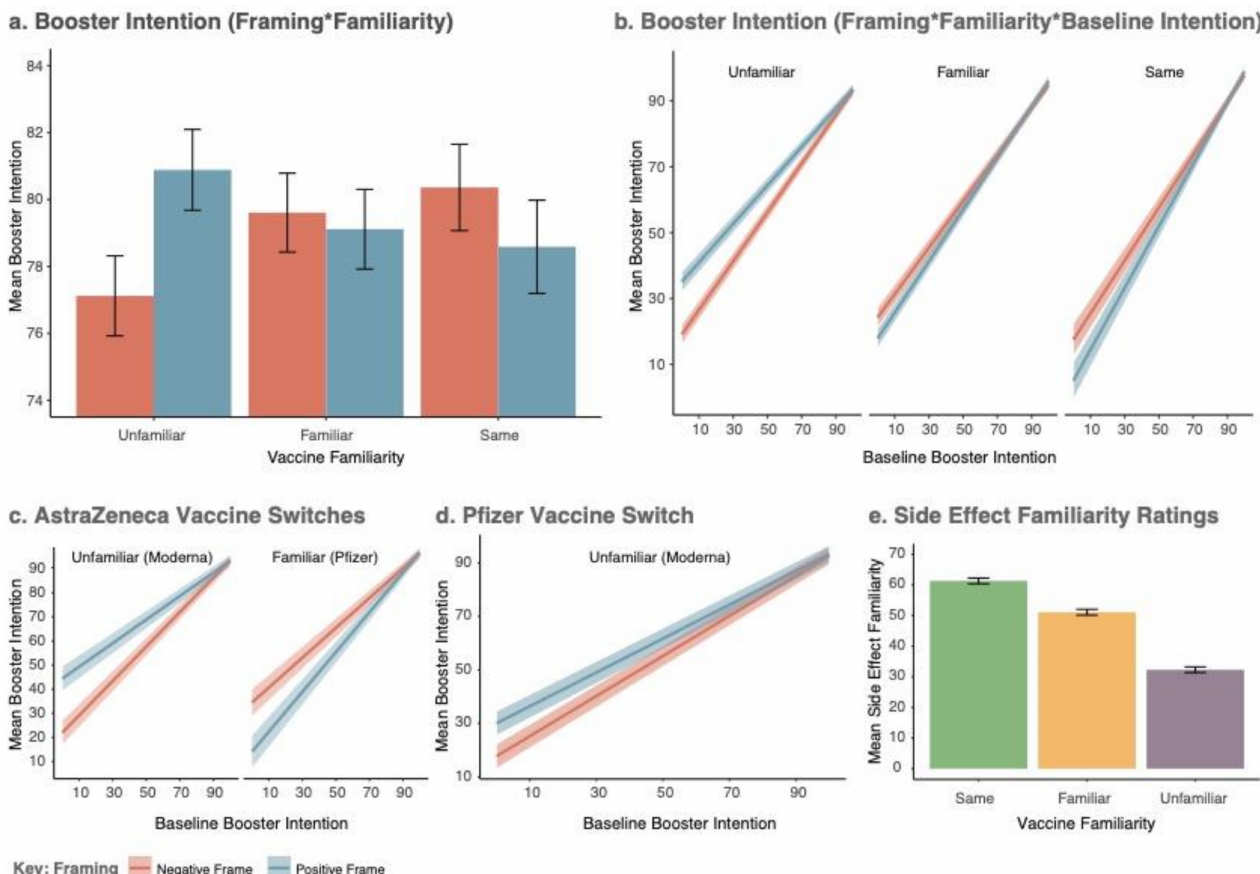
Figure 4. Model estimated mean differences in the primary outcome (Booster Intention), depicted for the whole sample (( a , b ); sample size by condition presented in Table 1), and for realistic switches occurring as part of the UK booster programme (( c , d ); AstraZeneca/Unfamiliar N = 206, As- traZeneca/Familiar N = 204, Pfizer/Unfamiliar N = 202, sample size by condition presented in Figure 2). ( e ) presents data demonstrating that side effect familiarity ratings scaled with the factorial levels of vaccine familiarity (within-subjects, full sample N = 1222). All error bars represent ±